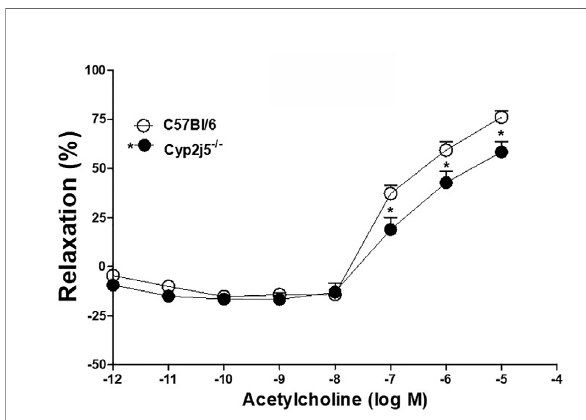
FIGURE 3 | Effect of angiotensin II (Ang-II) (10 − 6 M) on acetylcholine (Ach)- induced concentration dependent vascular response in aortic rings of C57Bl/ 6 and Cyp2j5 − / − mice. * P < 0.05 between non-treated C57Bl/6 vs . Ang-II treated C57Bl/6 mice, @ P < 0.05 between non-treated C57Bl/6 vs . non- treated Cyp2j5 − / − mice, # P < 0.05 between non-treated C57Bl/6 vs . Ang-II- treated Cyp2j5 − / − mice. #@ P < 0.05 between non-treated Cyp2j5 − / − and Ang- II treated Cyp2j5 − / − mice and between Ang-II treated Cyp2j5 − / − vs . Ang-II treated C57Bl/6 mice ( #* P > 0.05). Values expressed as means ± SE. n = eight per